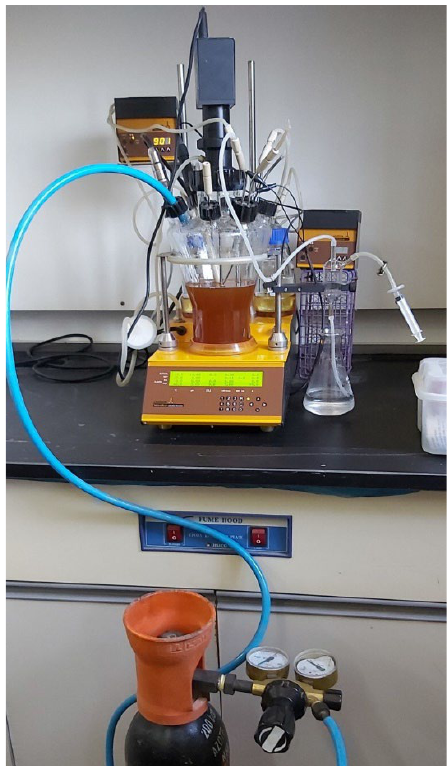
Figure 1. MixAlco fermentation process in LAMBDA MINIFOR